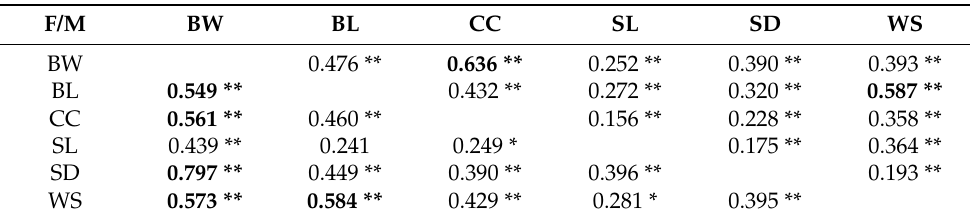
Table 6. Pearson’s Correlations between the zoometric measures and body weight for males (66 M: below diagonal) and females (426 F: above